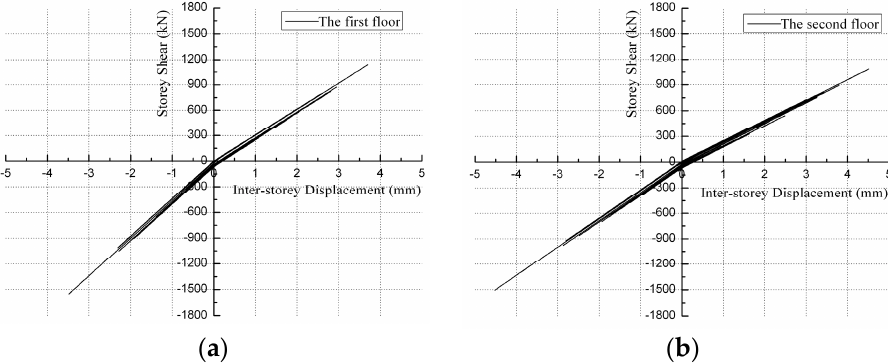
Figure 8. Relationship of the inter-story restoring force and story drift using the subdivided integral step for ( a ) the first floor, and ( b ) the second floor.